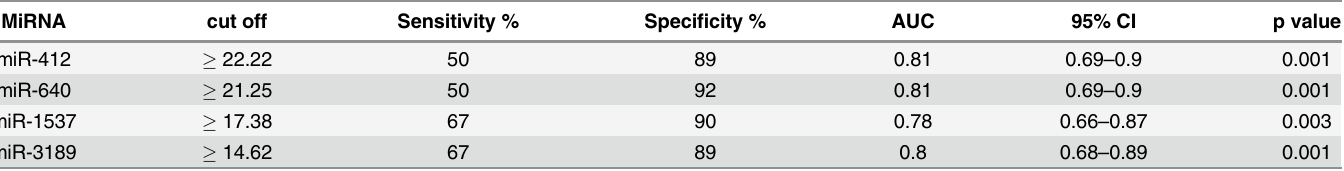
Table 4. Bile miRNA analysis. Sensitivity and specificity to distinguish between patients with primary sclerosing cholangitis (PSC) and cholangiocarcinoma complicating PSC (PSC/CC) in bile for the differentially expressed miRNAs. The analysis was optimized regarding specificity. Table 4 shows the sensitivity, specificity, cut off values, area under the curve (AUC) values with confidence interval (CI) and p-values.